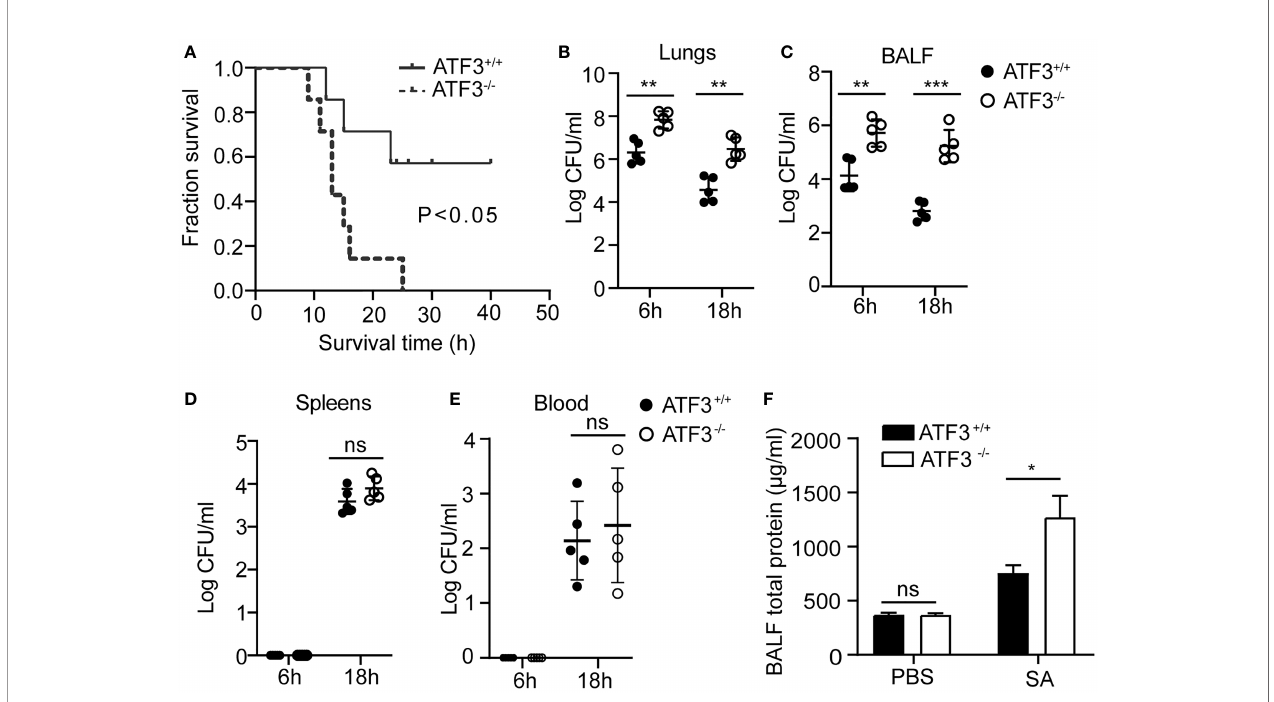
FIGURE 1 | ATF3 provides protection against S. aureus infections. (A) WT and ATF3 KO mice were challenged intratracheally with 2 × 10 8 CFU/mouse of a lethal inoculum of S. aureus (USA 300) and then observed to survive for 48 h. For the functional analysis, WT and ATF3 KO mice were infected intratracheally with a sublethal S. aureus inoculum (5 × 10 7 CFU/mouse) and then euthanized at 6h and 18hafter infection to quantify the bacterial load in the lungs (B) , BALF (C) , spleens (D) , and blood (E) . (F) Total protein in BALF was measured. ns, P > 0.05, * P < 0.05, ** P < 0.01, *** P <